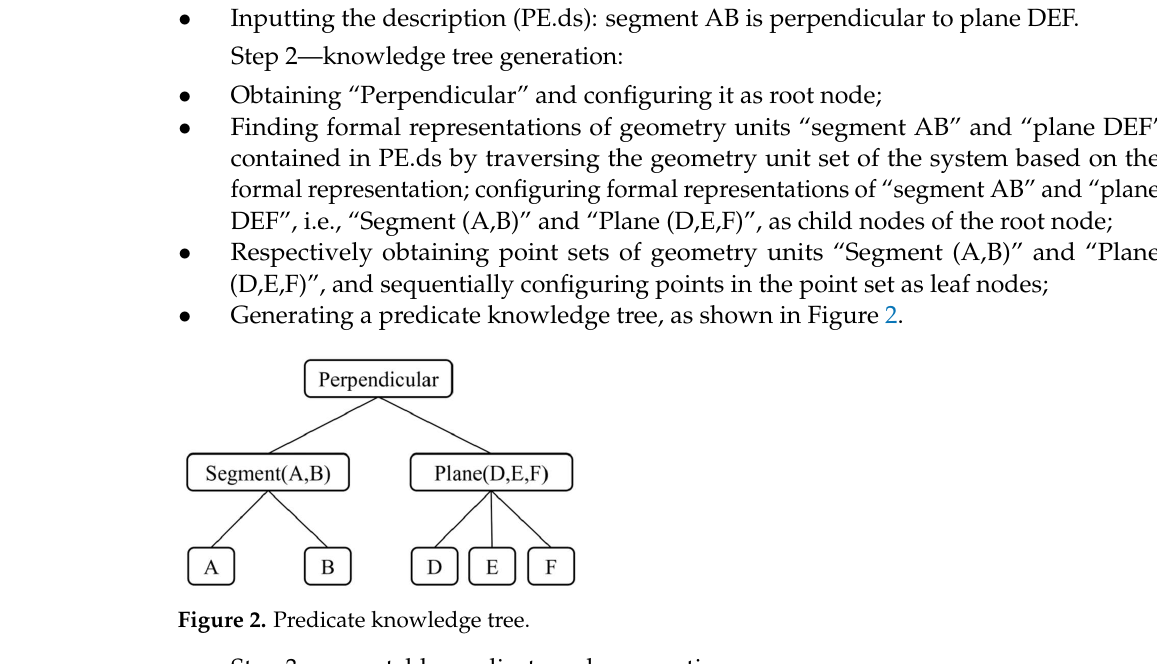
Figure 3. Predicate knowledge tree.